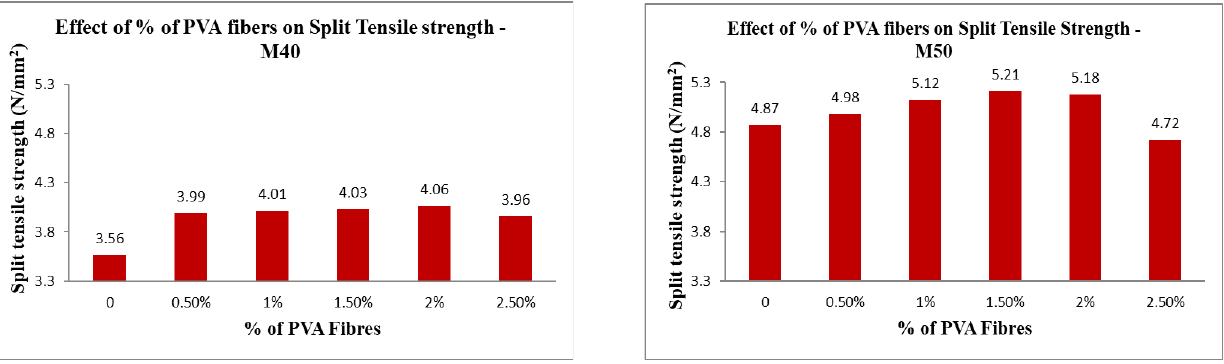
Figure 5. Comparison of Split tension test results on expansive cement concrete specimen.